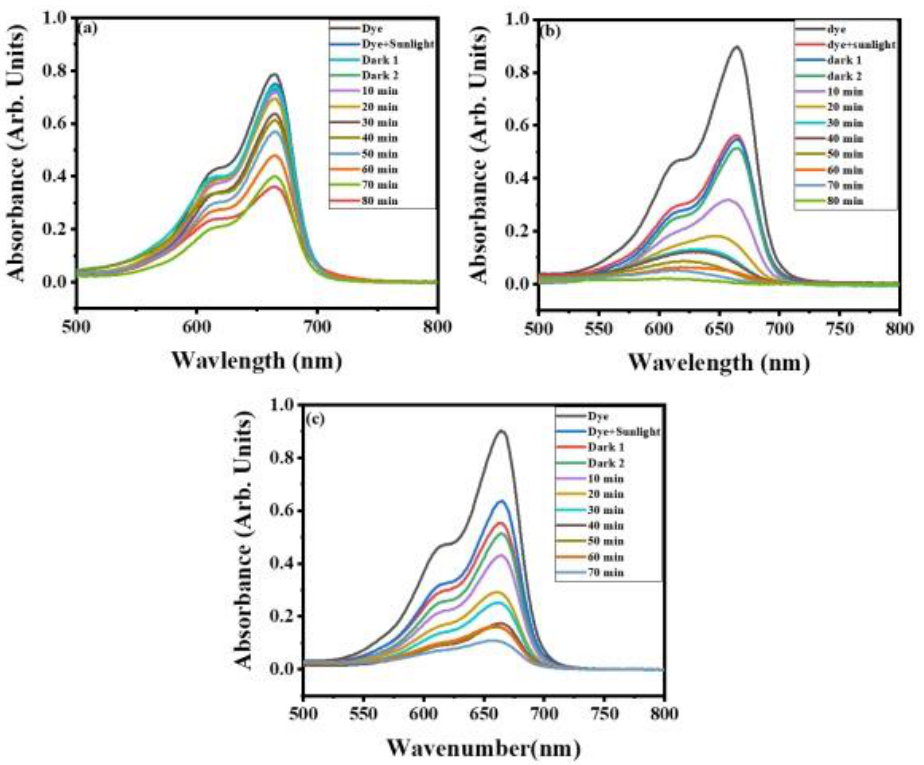
Figure 8. Absorption spectra for photocatalytic degradation of methylene blue by ( a ) MXene, ( b ) WO 3 , and ( c ) WO 3 /MXene nanocomposite.